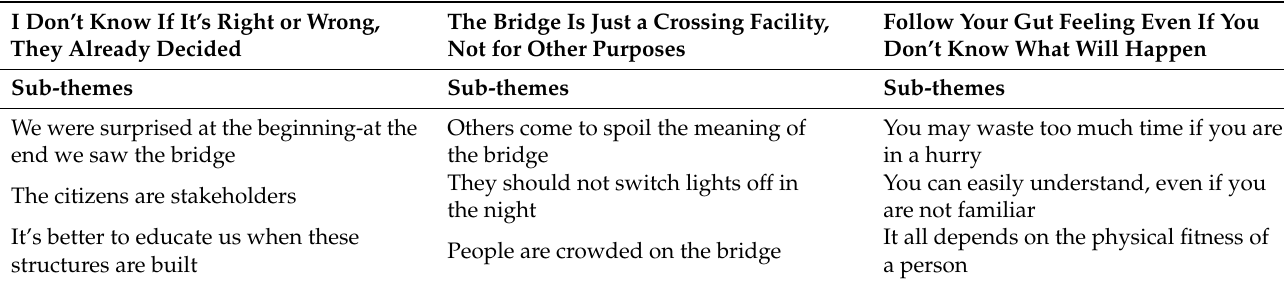
Table 3. Overarching